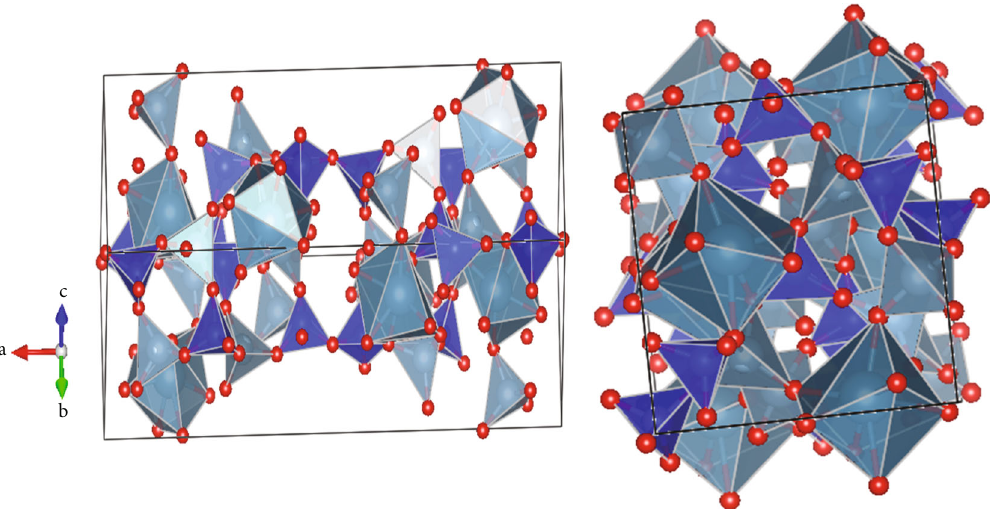
Figure 8: The crystal structure of gismondine (Ca